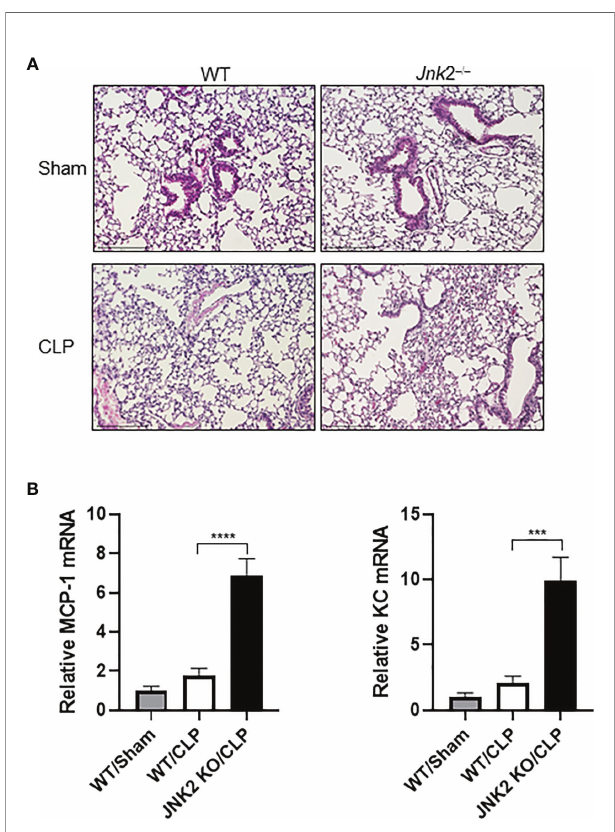
FIGURE 3 | JNK2 de fi ciency augments lung in fl ammation and injury in CLP- induced sepsis. (A) Sectional lung histology of sham- or CLP-treated wild-type and JNK2 KO mice. (B) mRNA expressions of MCP-1 and KC from whole lung homogenates of sham-treated wild type mice or CLP-treated wild-type and JNK2 KO mice. N=3. Data are presented as means ± sem. *** p < 0.001; **** p <